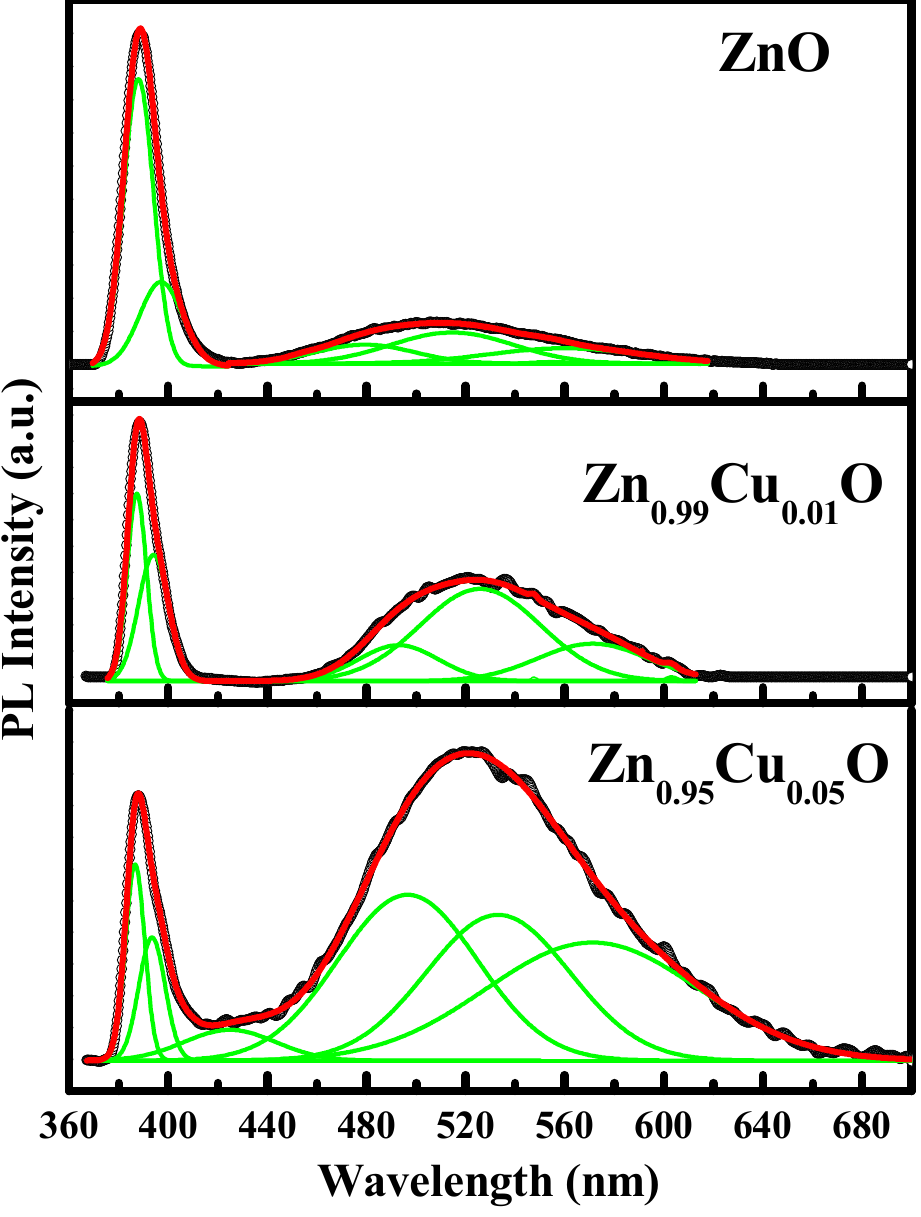
Figure 5. Room temperature photoluminescence spectra of Cu-doped ZnO nanostructures. Figure 6 shows the Raman spectra of the un-doped and Cu-doped ZnO nanostructures ranging from 200–1000 cm − 1 to examine how the Cu dopant affects the Raman scattering in the doped samples. The highest intensity mode indicated as E High at around 438 cm − 1 2 corresponds to the characteristic band of ZnO with a hexagonal wurtzite geometry, and this might be attributed to the non-polar phonon vibrations of ZnO. As shown in Figure 6, the intensity of E (cid:2870)(cid:2892)(cid:2919)(cid:2917)(cid:2918) decreases with the Cu doping concentration, indicating